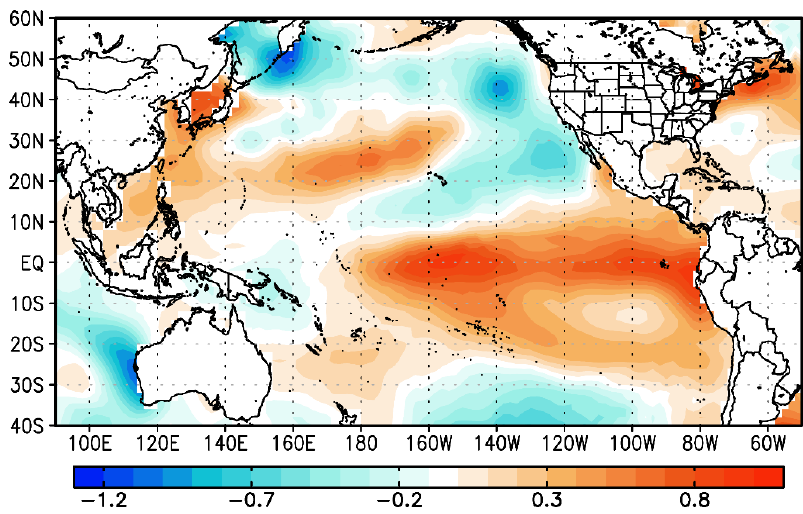
Figure 2. Pacific sea surface temperature anomalies in 1953 based on the NOAA Extended Recon- structed SST V5 dataset [26].